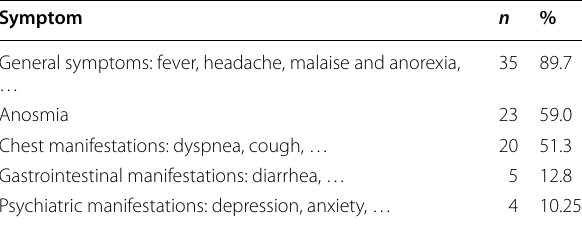
Table 1 Most common COVID-19 symptoms in MS